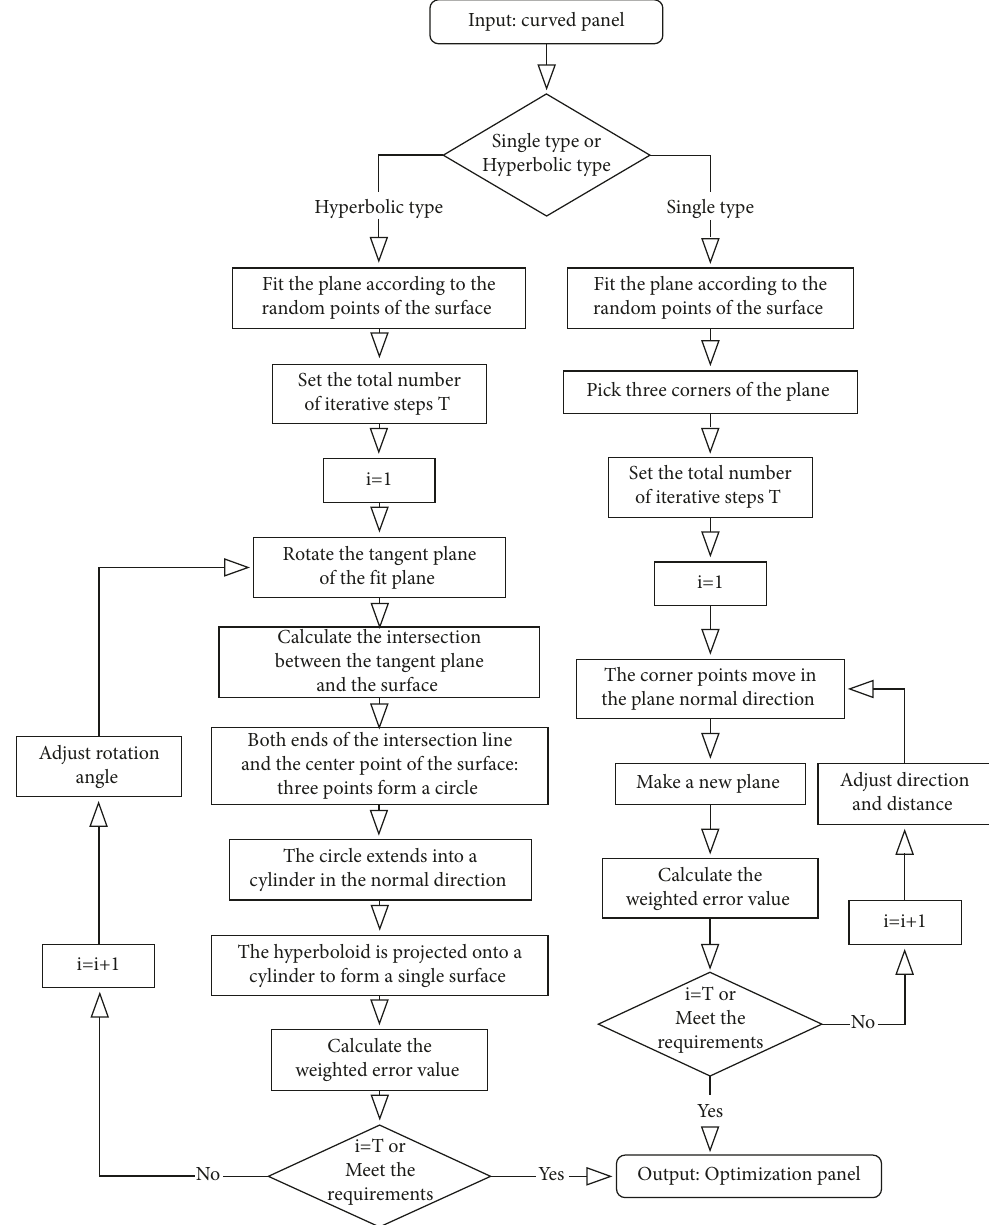
Figure 4: GA single-objective optimization